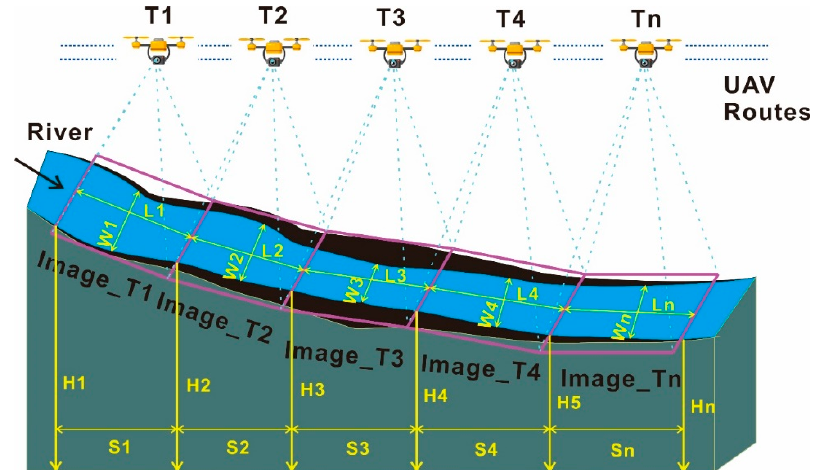
Figure 4. Schematic of the river channel survey and hydrological parameters obtained from the UAV. W is the width of the water surface, L is the length of the river channel, H is the elevation of the river channel, and S is the horizontal distance of the river channel.